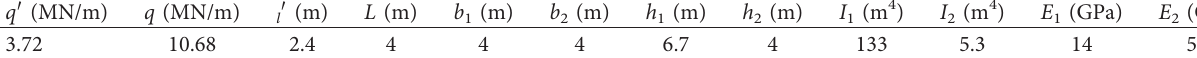
Table 3: Detailed values of parameters in Baizi Coal Mine.